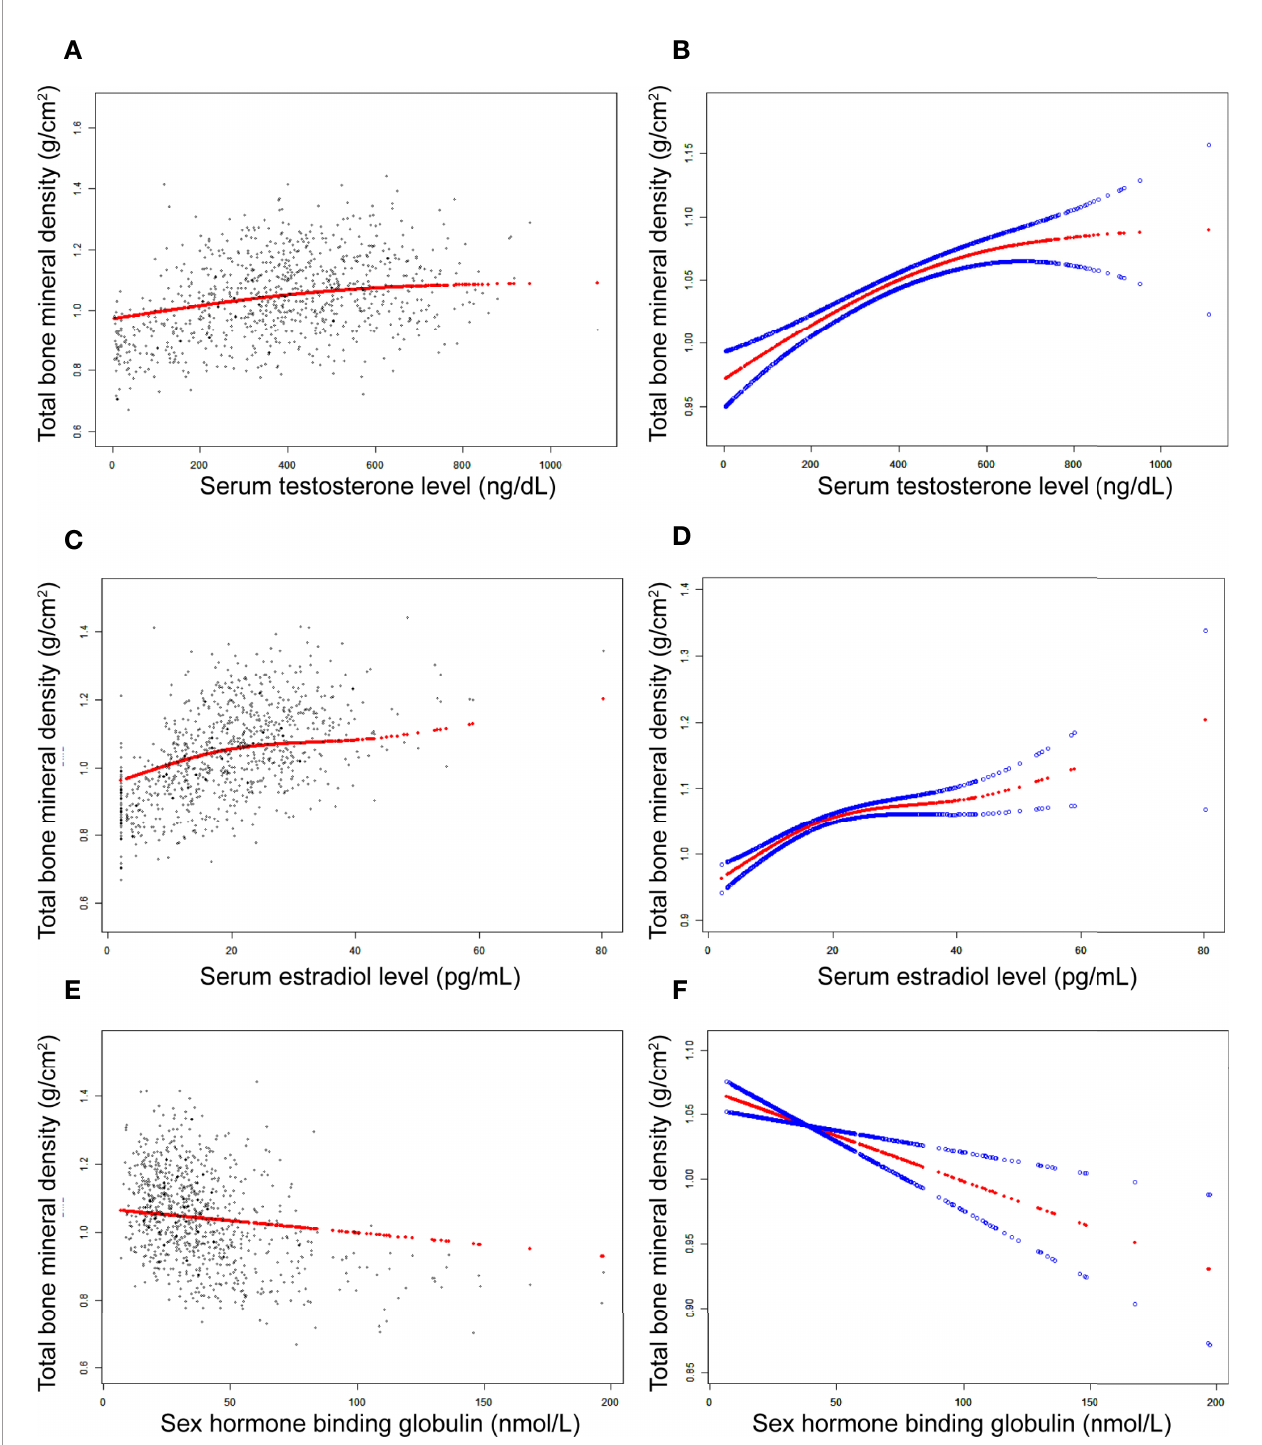
FIGURE 2 | The association between testosterone (A, B) , estradiol (C, D) , and SHBG (E, F) and total bone mineral density in boys, respectively. (A, C, E) Each black point represents a sample. (B, D, F) Solid red line represents the smooth curve fi t between variables. Blue bands represent the 95% of con fi dence interval from the fi t. Adjusted for age, race, body mass index, ratio of family income to poverty, moderate activities, blood urea nitrogen, serum uric acid, total protein, total cholesterol, serum phosphorus, and serum